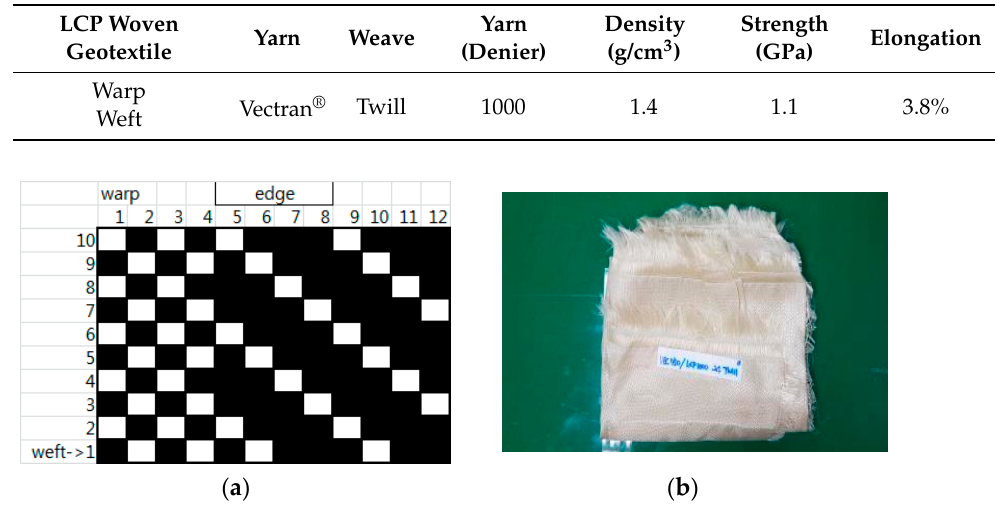
Table 1. Specifications of LCP woven geotextile.